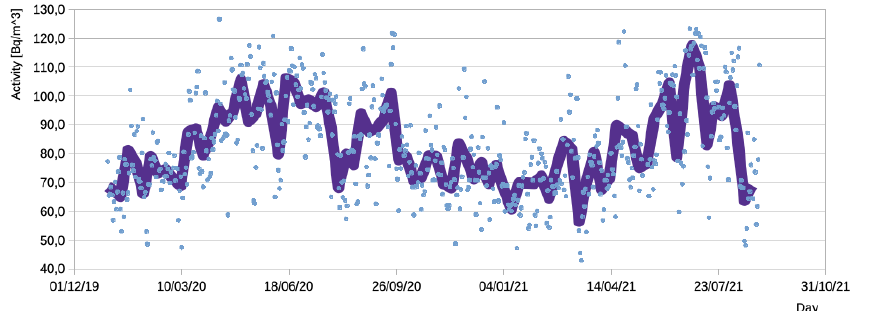
Figure 3. Radon measurements inside Hall A. Light blue points show the daily measurements and the violet line shows the weekly mean